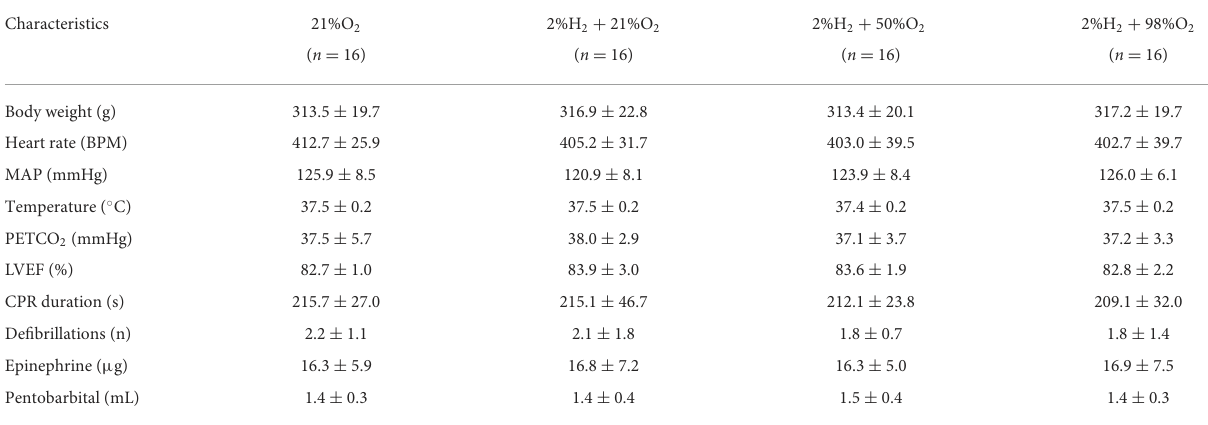
TABLE 2 Baseline and cardiopulmonary resuscitation (CPR) characteristics for animals under hypothermia.